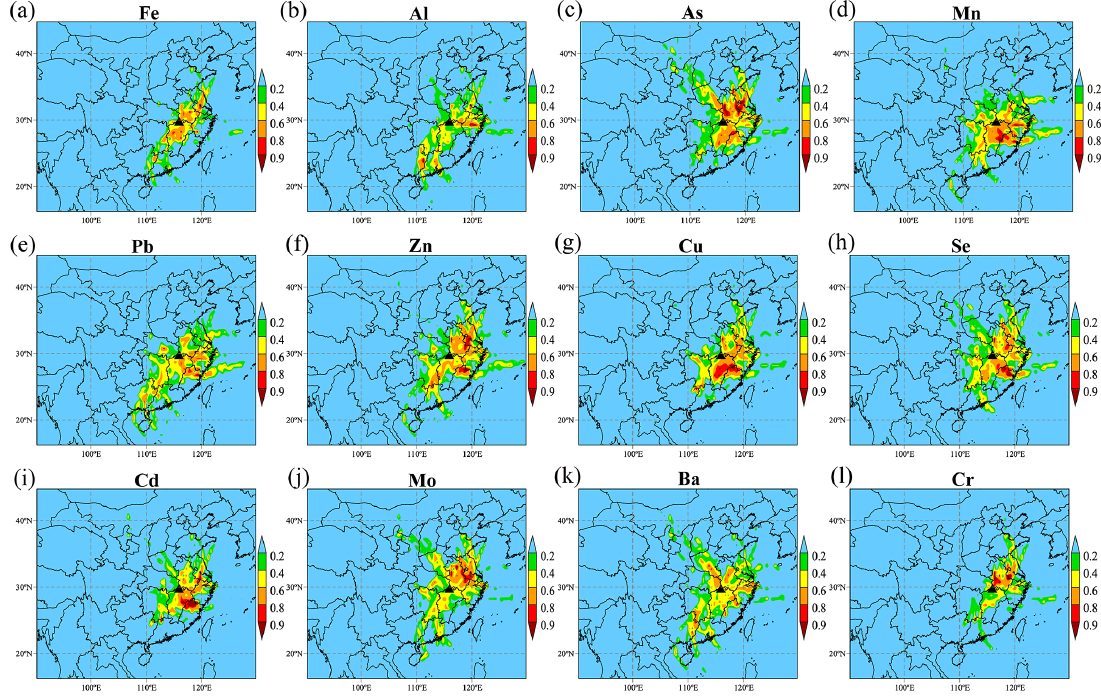
Figure 9. Solubility distributions in likely source regions for individual elements in PM 2 . 5 at Mt. Lushan, identified by PSCF with the mean solubility values as